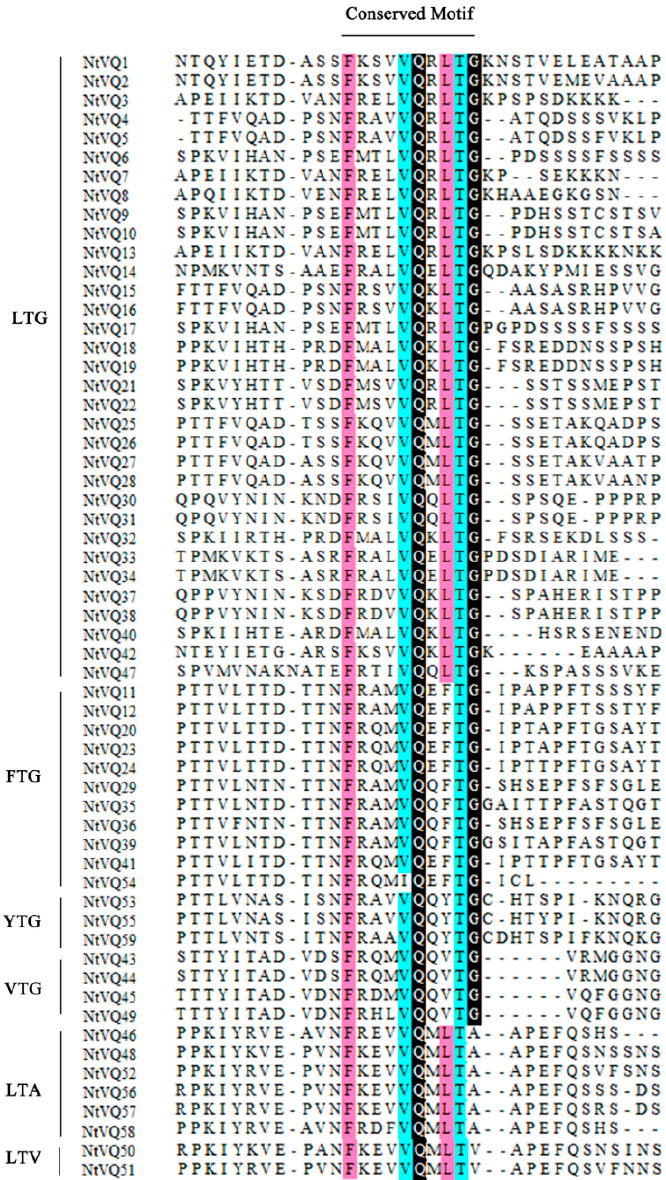
Figure 2. Multiple sequence alignment of the VQ motif based on their entire VQ protein length for the VQ proteins in tobacco. Multiple sequence alignment of the VQ motif for 59 NtVQ proteins showing the highly conserved FxxxVQxLTG motif, which can be further divided into several subgroups such as LTG, FTG, YTG, etc., based on the last three amino acids.